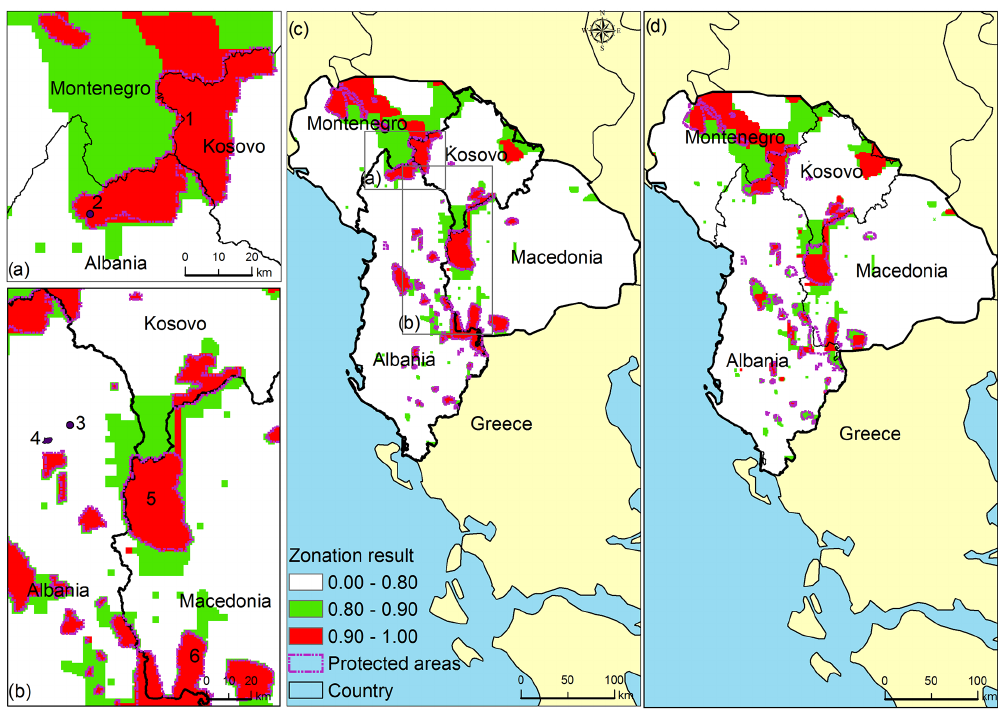
Figure 3. Priority locations for extending current protected areas for lynx conservation (a) in the cross-border area of Montenegro, Albania, and Kosovo; (b) in the cross border area of Albania, Macedonia, and Kosovo; (c) the top 10 and 20% of the landscape for lynx conservation as prioritised by Zonation constrained to the current protected areas (dashed lines); (d) result of unconstrained solution by